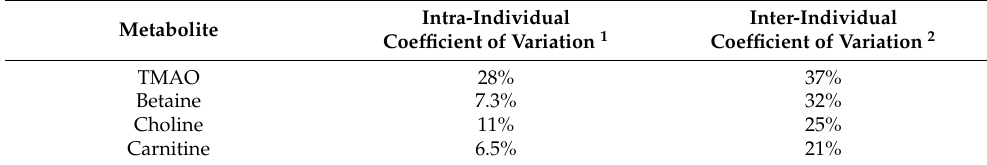
Table 4. Intra- and inter-individual variations of plasma concentrations of TMAO and dietary